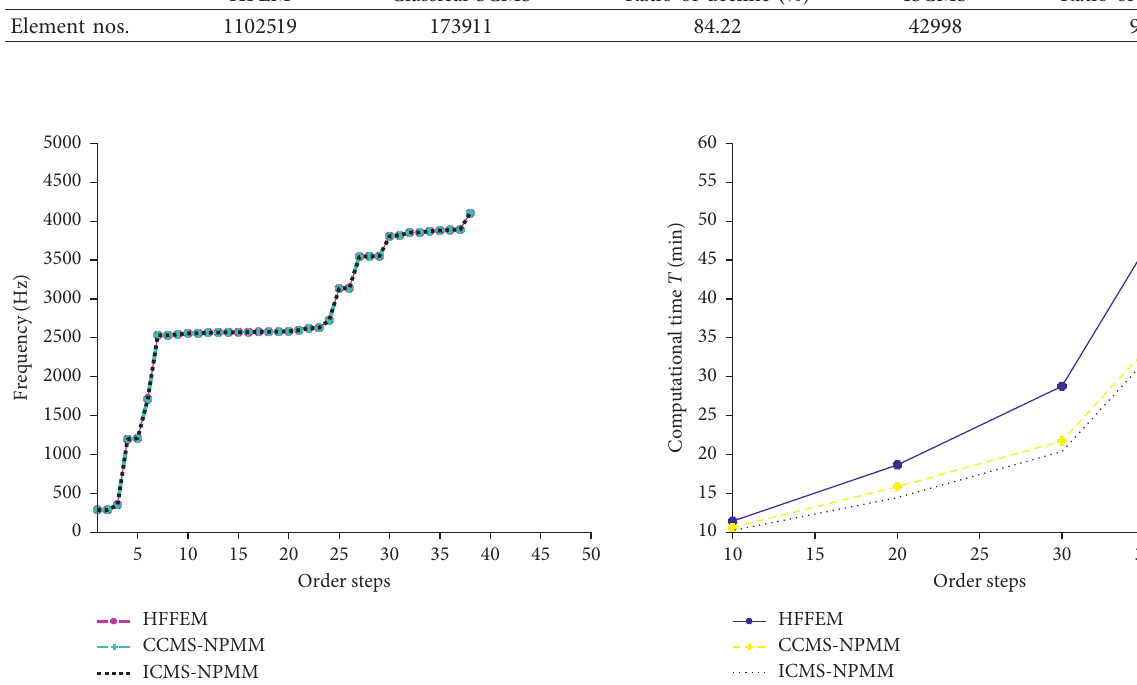
Figure 6: Intrinsic frequency analysis. Figure 7: Computational time of different order